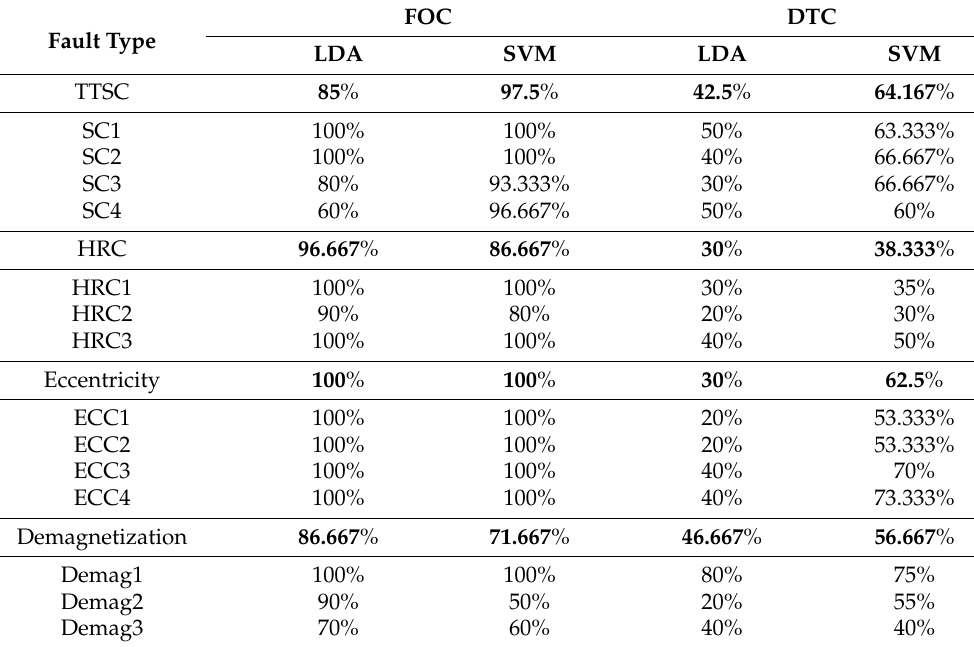
Table 7. The accuracy of fault severity estimation using MVSA approach for FOC- and DTC- driven